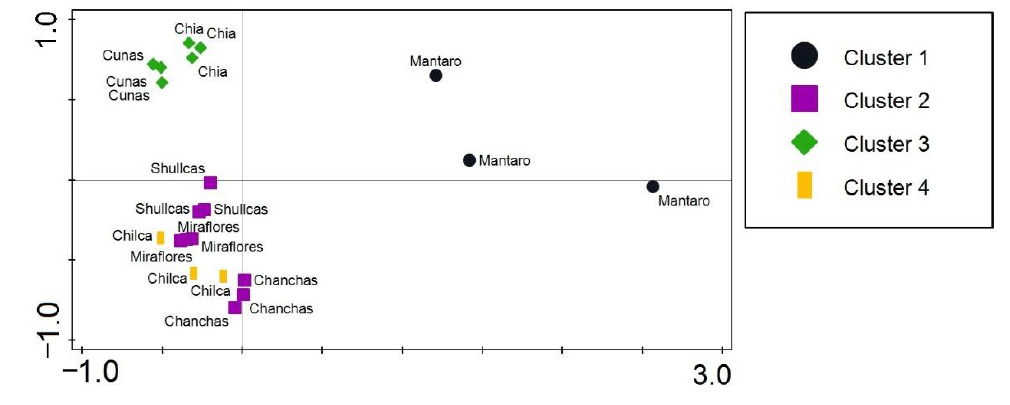
Figure 3. Distribution of observations and hierarchical clustering by river.